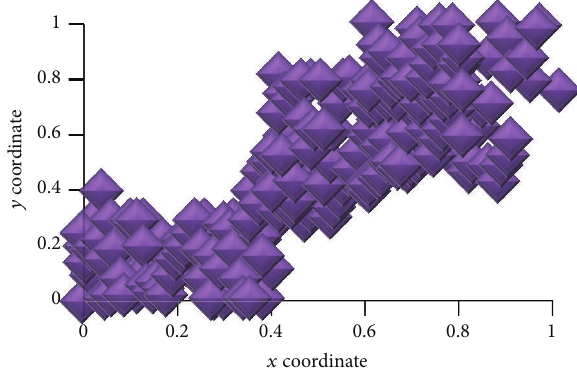
Figure 2: Initial position of